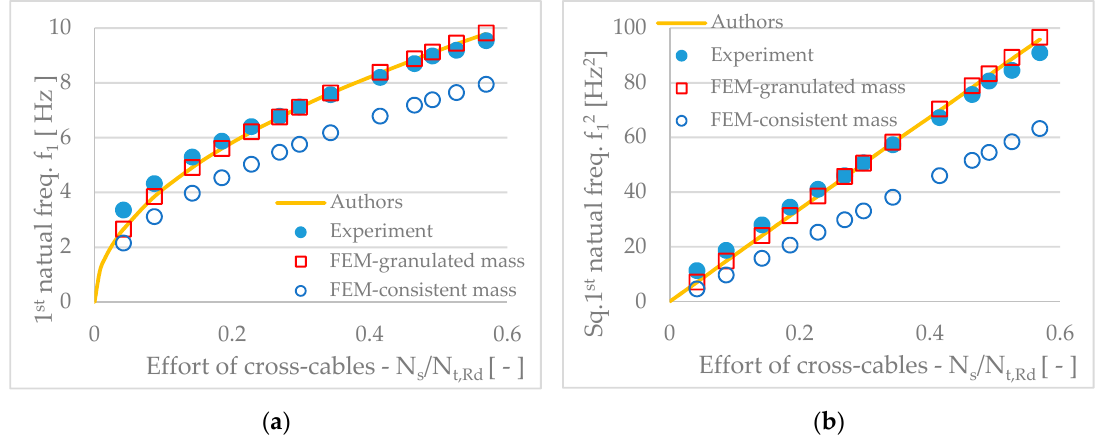
Figure 9. The effect of the prestress level on: ( a ) the first natural frequency; ( b ) the square of the first natural frequency.